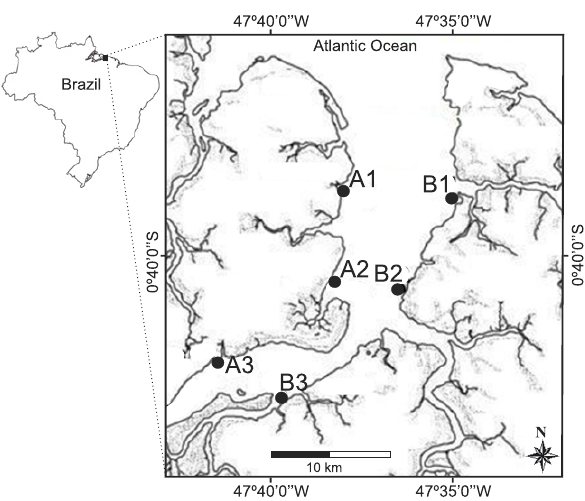
Figure 1. Sampling sites ( (cid:122) ) where the larvae and adults of Petrolisthes armatus were monthly collected at Marapanim estu- ary, northern Brazilian coast, between August 2006 and July